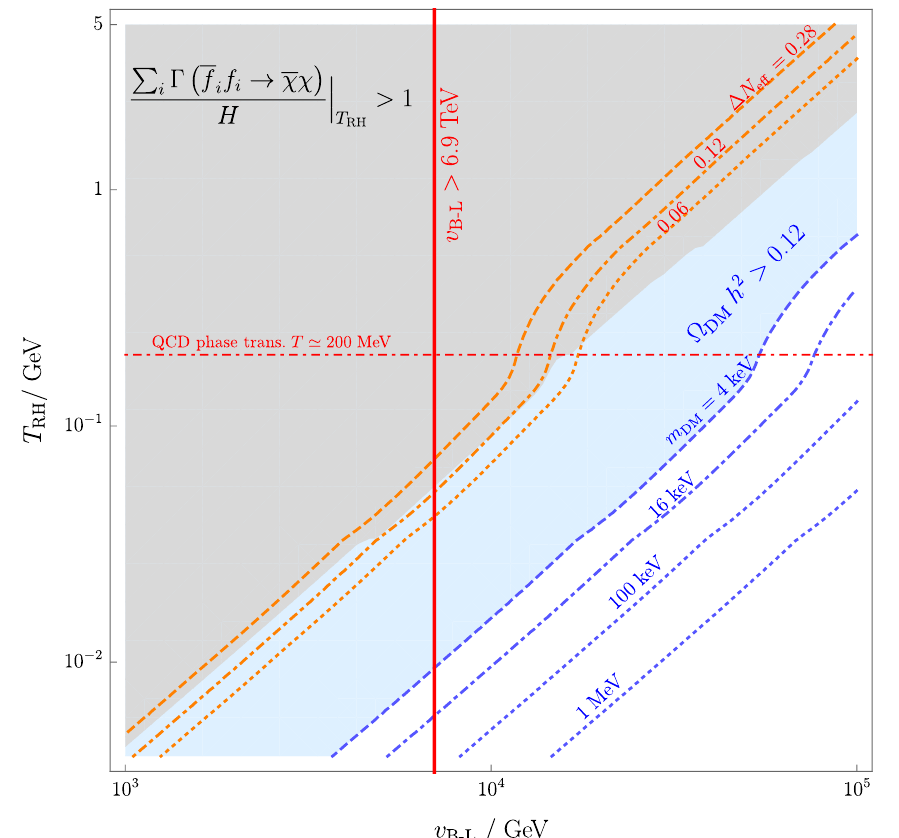
Figure 7 . We depict the allowed combinations of the reheating temperature T RH and the scale of B-L breaking v . The blue shaded area indicates where DM would overclose the universe B-L and the blue contours reproduce the observed DM relic density for m